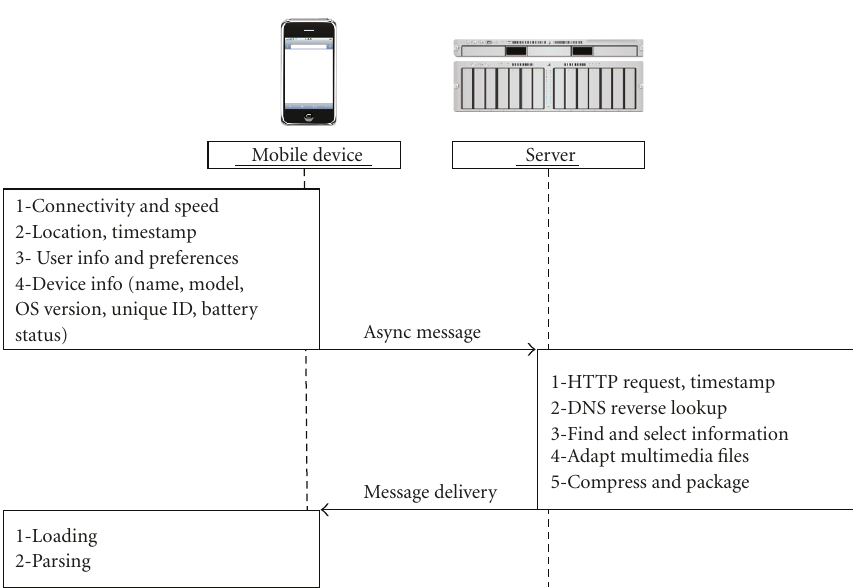
Figure 4: Sequence diagram model with context-awareness information and process variables to ubiquitously perform output